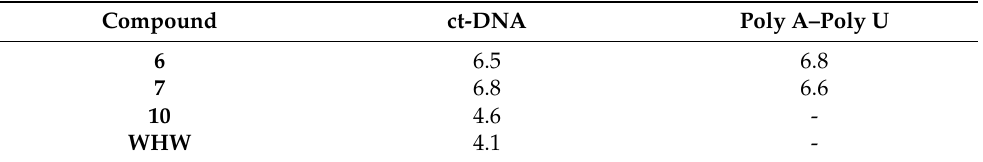
Table 2. Binding constants (log K s ) a and spectroscopic properties of complexes of the conjugates 6 , 7 and 10 with ds-polynucleotides, calculated by processing fluorimetric titrations, performed at pH = 7.0, sodium cacodylate buffer, I = 0.05